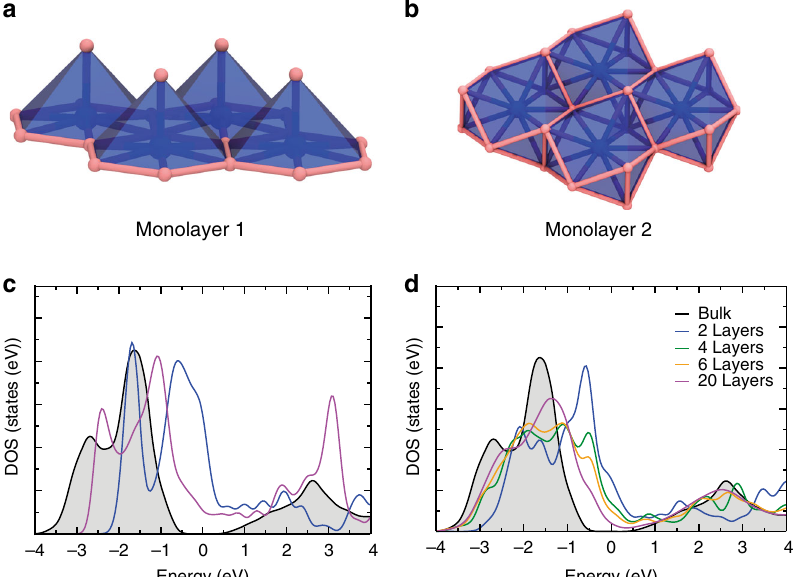
Fig. 5 Li 3 N monolayer con fi gurations and electronic structures determined from density functional theory calculations. Calculated Li 3 N monolayer structures of: a form 1; b form 2; c comparison of the total DOS for bulk Li 3 N (black) with form 1 (blue) and 2 (magenta) monolayers, respectively; d evolution of the total DOS for increasing numbers of Li 3 N layers (2 (blue), 4 (green), 6 (yellow) and 20 (magenta)) as compared to that of the bulk material